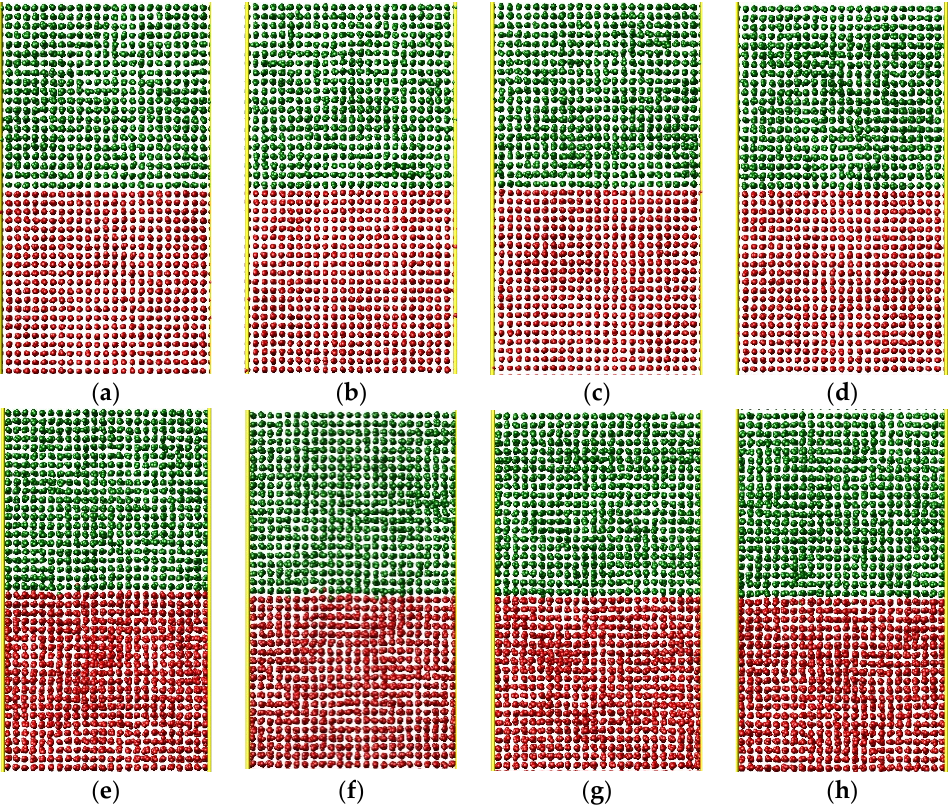
Figure 12. The calculated results of the model with FCC γ Fe and FCC Cu: ( a ) 750 °C; ( b ) 800 °C; ( c ) 850 °C; ( d ) 900 °C; ( e ) 950 °C; ( f ) 980 °C; ( g ) 1000 °C; ( h ) 1050 °C.